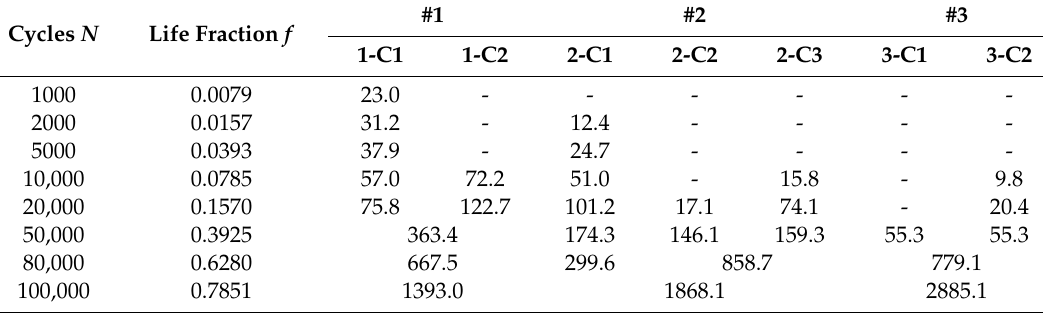
Table 2. Crack lengths of specimen ORB2 (unit: µ m).